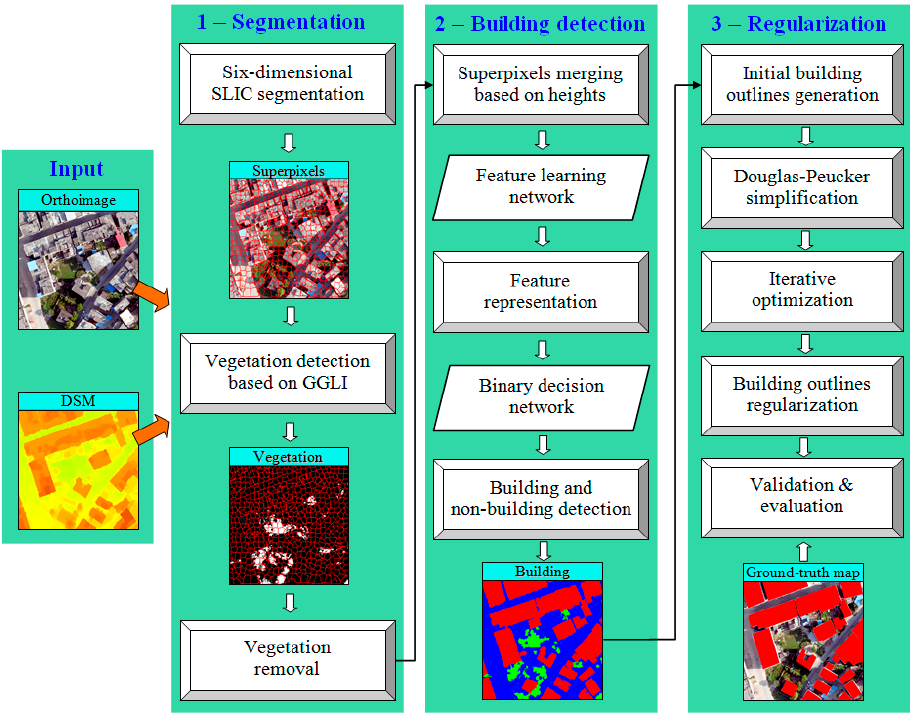
Figure 1. The proposed framework for building extraction.